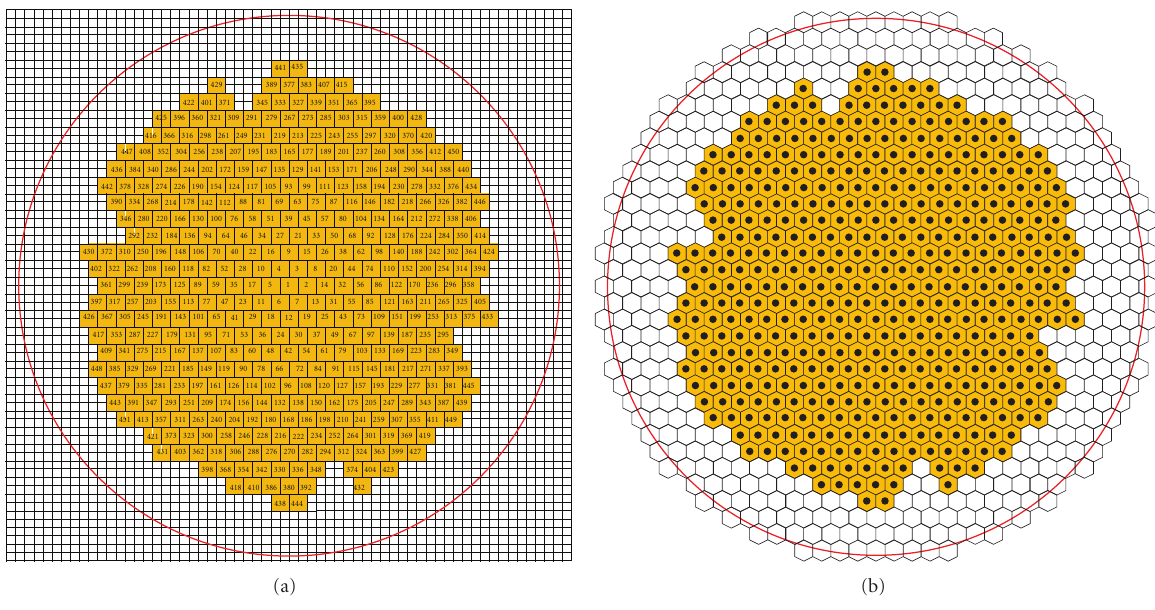
Figure 6: Core model cartesian (a) and hexagonal (b).